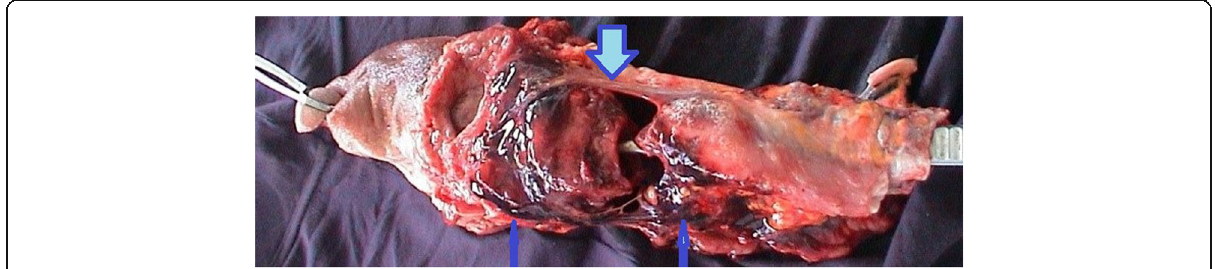
Fig. 2 The thin arrows show a haemorrhagic infiltration of the neck muscles, and the thick arrow shows a rupture of the oesophagus and trachea at the third tracheal ring in case